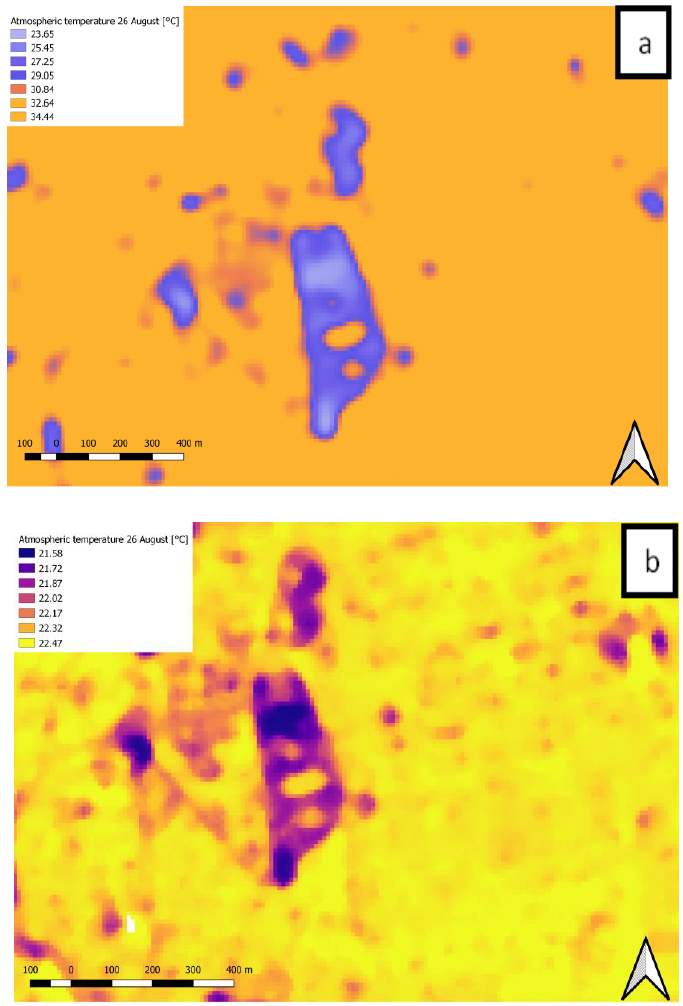
Figure 9. Daytime ( a ) and nighttime ( b ) atmospheric temperature on 26 August 2017.